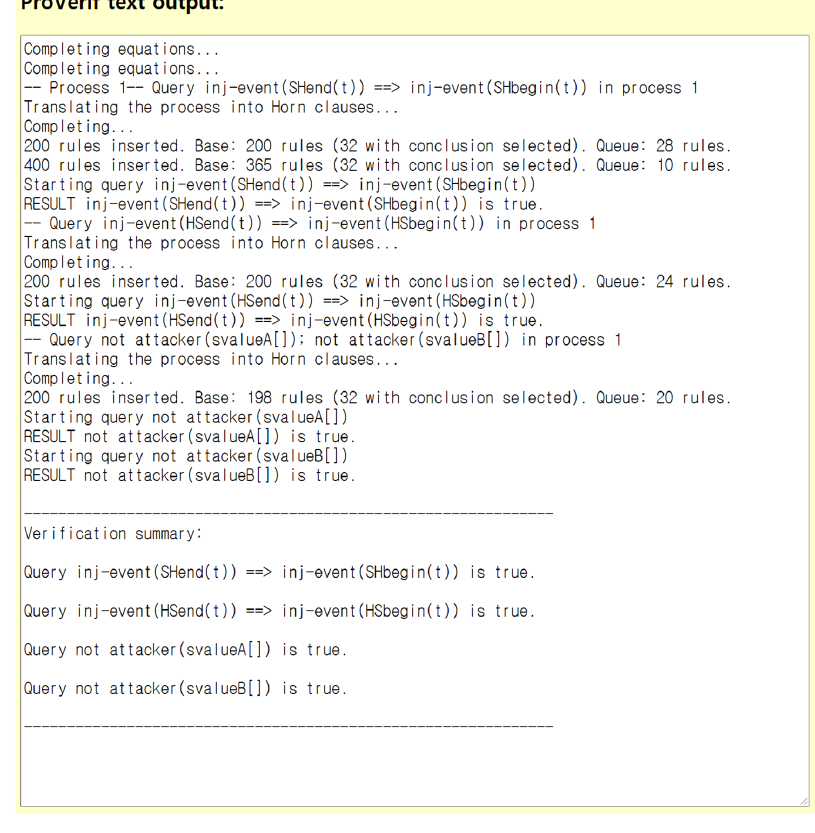
Figure 4. ProVerif